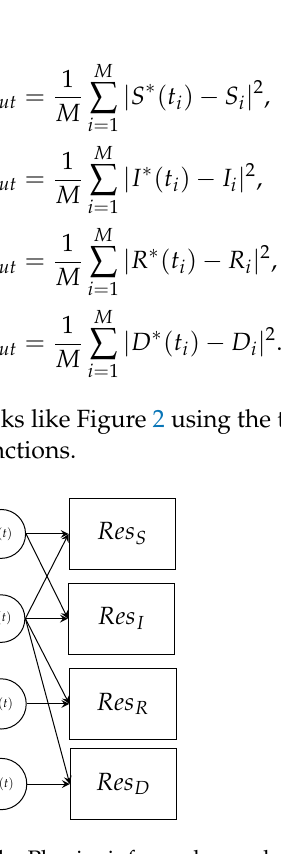
Figure 2. A schematic representation of the Physics informed neural network, which takes an input of time (t) and outputs Susceptible ( S ), Infected ( I ), Recovered ( R ) and Deceased D . The output is subjected to